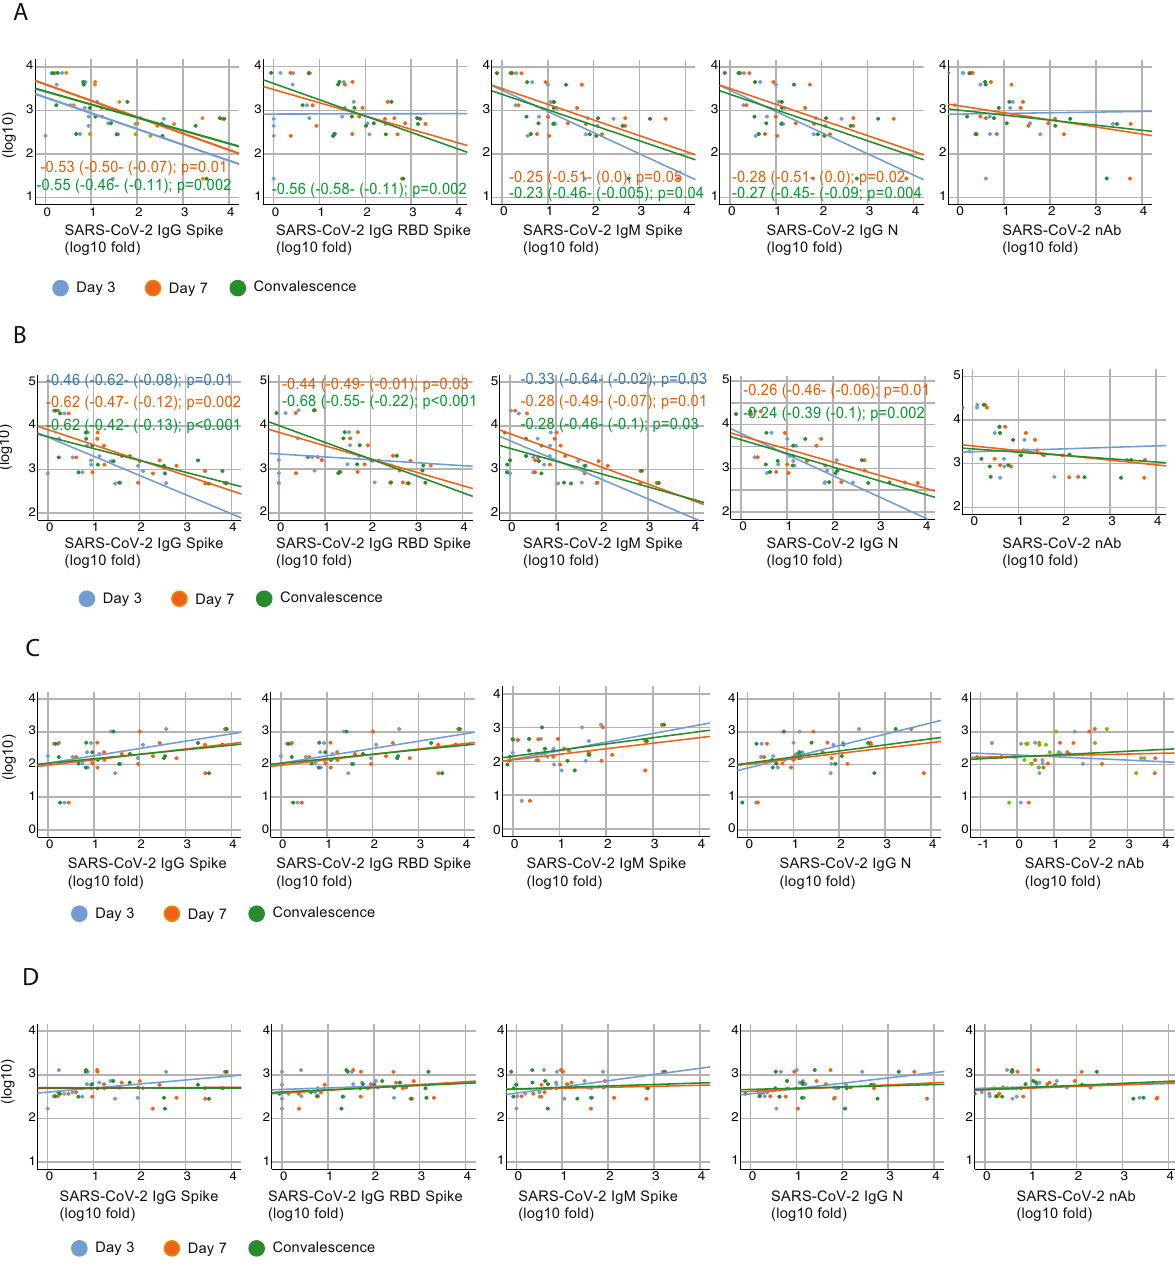
Fig. 6 Cross-reactivity with conserved epitopes against selected betacoronaviruses predicts negative in fl uence on de novo anti-SARS-CoV-2 antibody responses. A – D Scatterplot of baseline IgG levels for HKU1, OC43 and 229E S protein; and HKU1 S1 and fold induction of SARS-CoV-2 antibodies: neutralizing (nAb), IgG spike, IgG RBD, IgM spike, and nucleoprotein. Overlay shows relationship with induction of de novo antibodies against SARS-CoV-2 at each time point. Fitted linear regression and standardized beta coef fi cient (95% Con fi dence Interval, CI) for signi fi cant linear regressions are shown. Reported p values are based on two ‐ tailed antibody induction at day 7. Importantly, immunity to other normalization limited the induction of neutralizing antibody betacoronavirus spikes, like HKU1 and OC43, limited the levels after in the follow-up. induction of de novo responses to all SARS-CoV-2 antigens While we could not fi nd statistically signi fi cant differences for tested. All patients also developed detectable levels of spike IgG/ antibody levels in patients with mild vs. severe disease, the latter IgM and N IgG. Although no signi fi cant correlation was found showed a delay in antibody responses. Moreover, anti-SARS- between pre-exposure to seasonal coronaviruses and induction of CoV-2 antibodies inversely correlated with viral loads in protective antibodies with neutralizing activity, simple linear respiratory samples, whereas virus clearance could not be linked regression estimated a negative relationship, and the predicted to back-boosting of antibodies toward the S2 subunit of the line approximated a negative in fl uence on development of de seasonal human coronaviruses. Importantly, several reports have novo neutralizing antibodies over time. Similarly, baseline anti- shown cross-reactivity between pre-existing memory T cells to body levels to HKU1 or OC43 spike after SARS-CoV-2 IgG levels seasonal coronaviruses and SARS-CoV-2 25,48 pointing to a